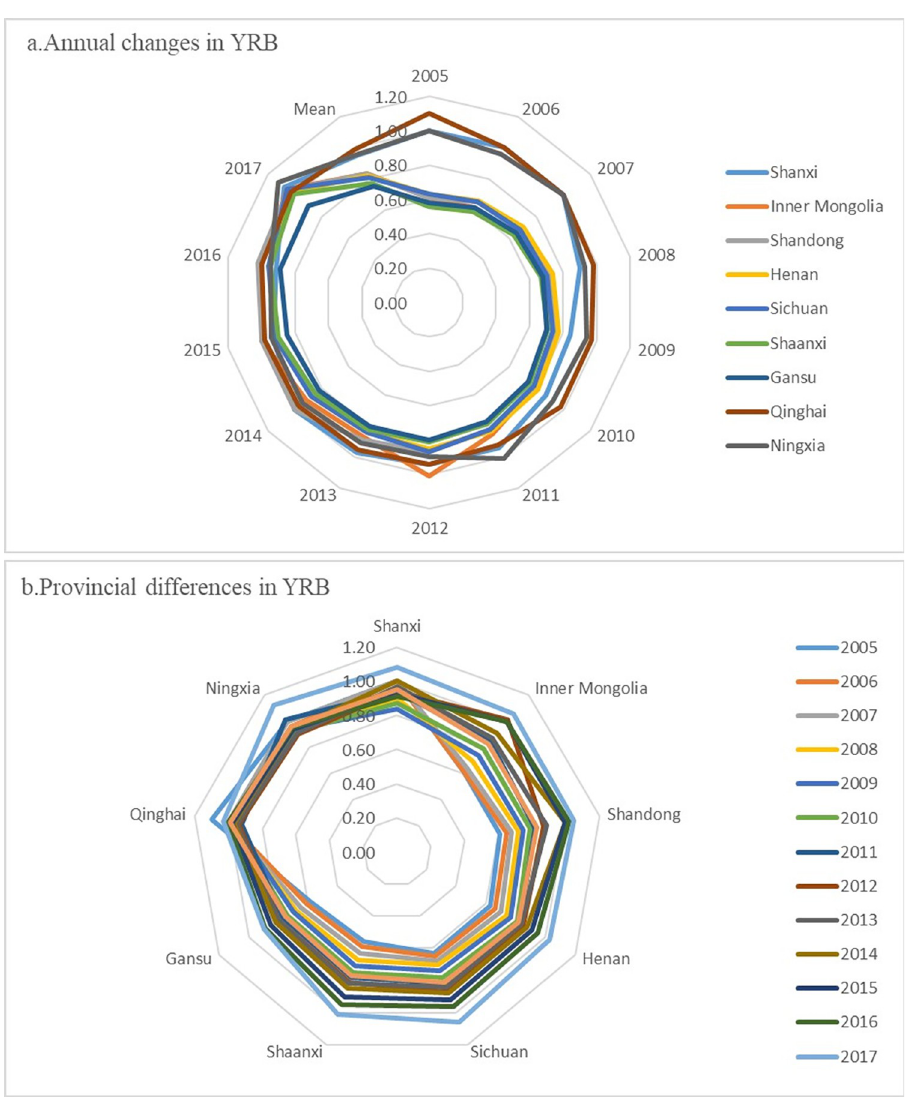
Fig 4. Radar chart of comprehensive energy efficiency in the